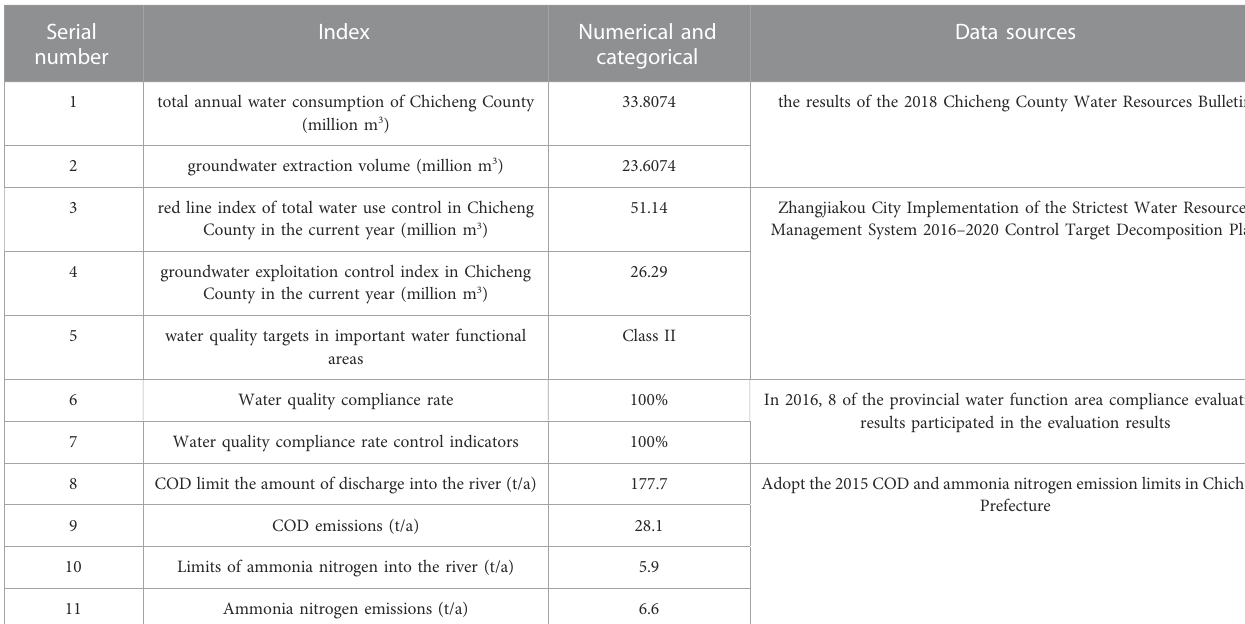
TABLE 2 Data acquisition and